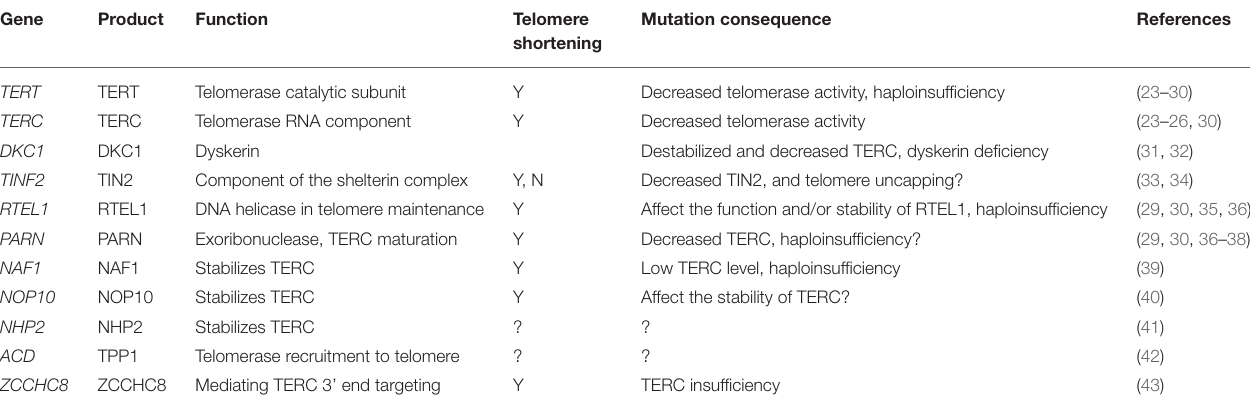
TABLE 1 | Gene mutations associated with telomere dysfunction in idiopathic pulmonary